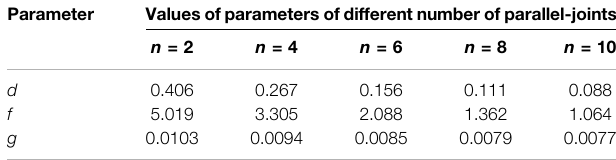
TABLE 4 | Values of parameters d , f , and g of different number of parallel-joints. Parameter Values of parameters of different number of parallel-joints